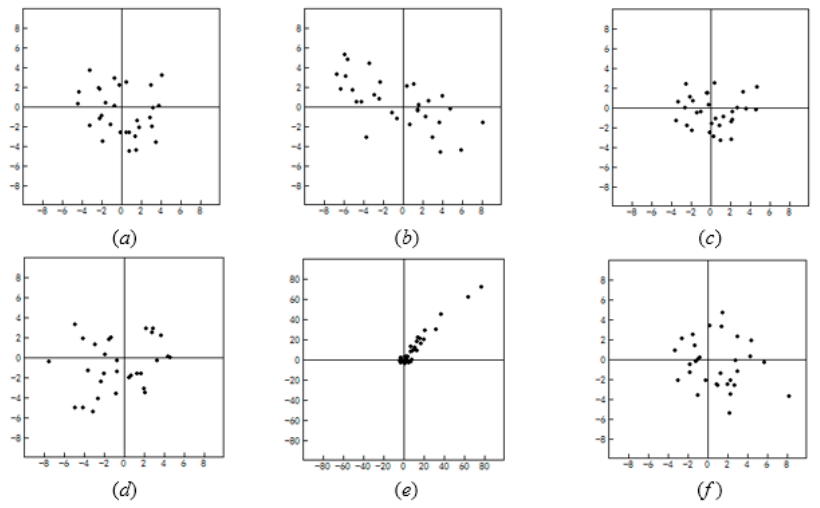
Figure 8. ( a – f ) Control point residuals. The first and second rows correspond to 1st-order and 2nd-order polynomial models, respectively. Left ( a ) and ( d ) SC, middle ( b ) and ( e ) SIFT, right ( c ) and ( f ) SC+SIFT.